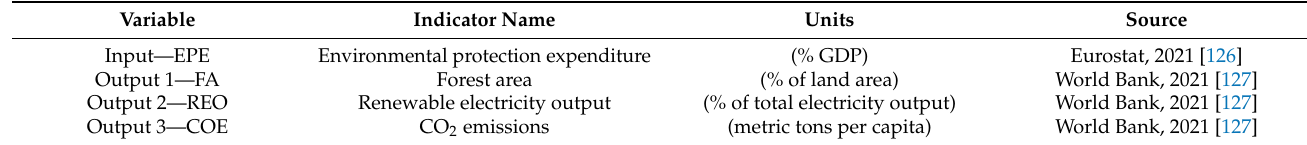
Table 1. Indicators and Sources.